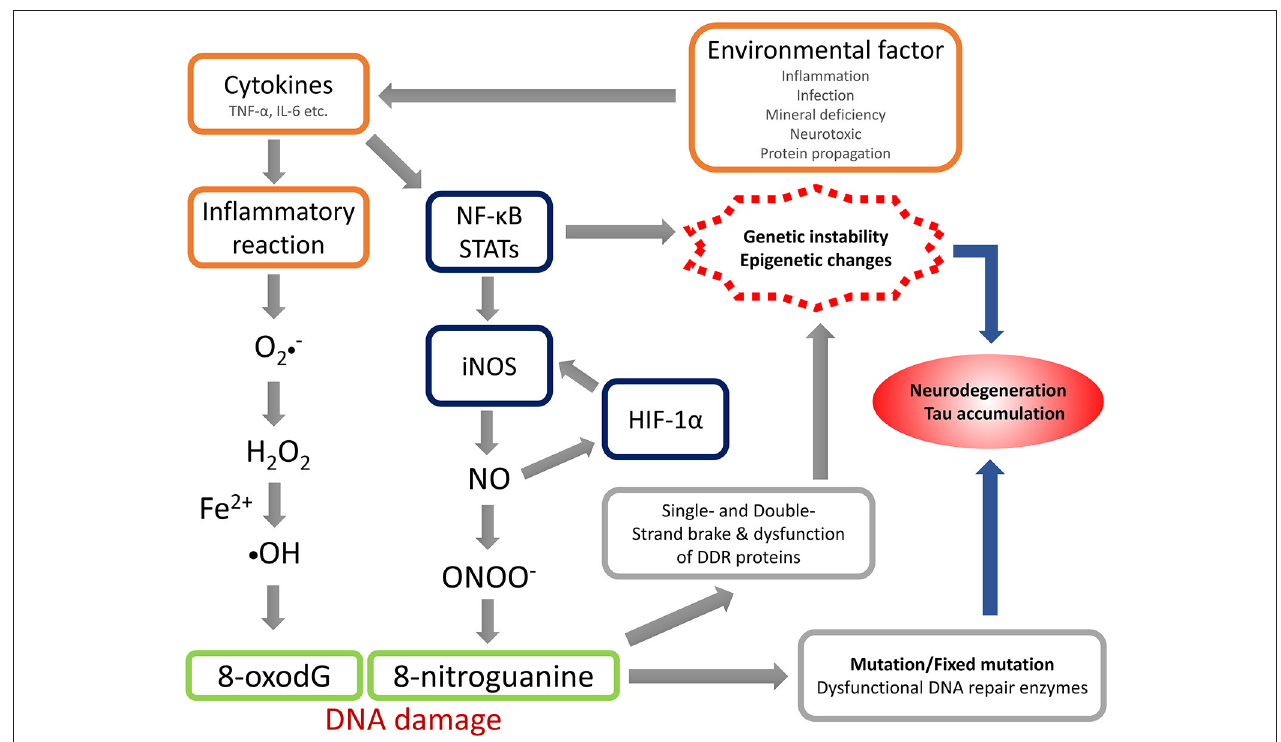
FIGURE 3 | Hypothesis of nitrative stress in the pathomechanism of Kii ALS/PDC. TNF- α , tumor necrosis factor- α ; IL-6, interleukin-6; NF- κ B, nuclear factor-kappa B; STATs, signal transducers and activators of transcriptions; iNOS, inducible nitric oxide synthase; HIF-1 α , hypoxia Inducible Factor-1 α ; NO, nitric oxide; DDR, DNA damage